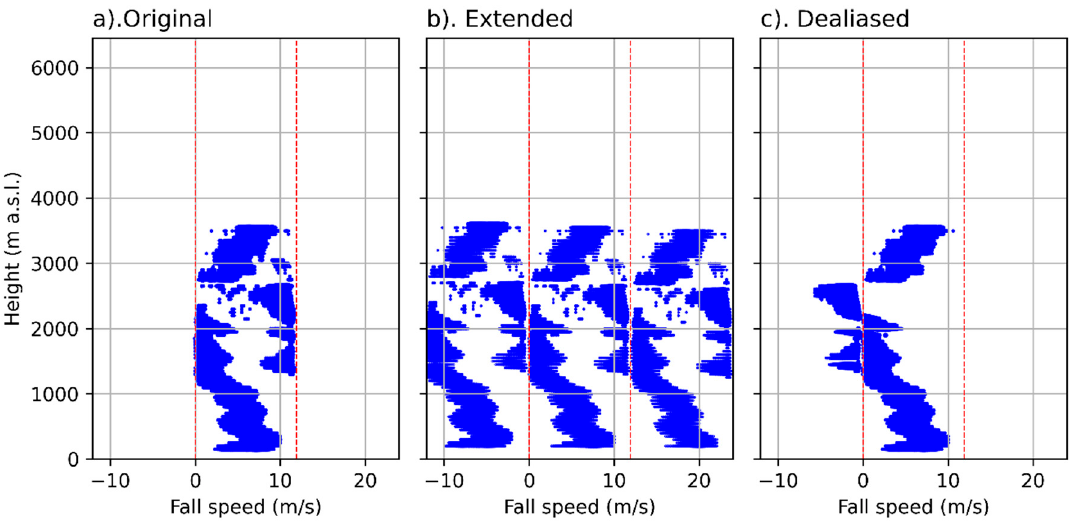
Figure A3. Doppler velocity dealiasing applied with RaProm- Pro compared to the original data (27 July 2019, 10:16:30 UTC). Original Doppler spectra profile ( a ), extended Doppler spectra profile ( b ) and final dealiased Doppler spectra profile ( c ).